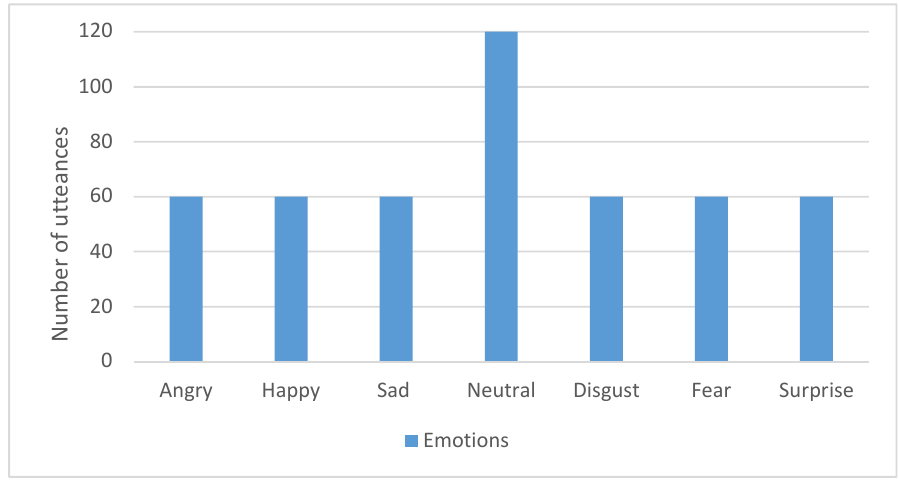
Figure 2. The Surrey audio-visual expressed emotion (SAVEE).